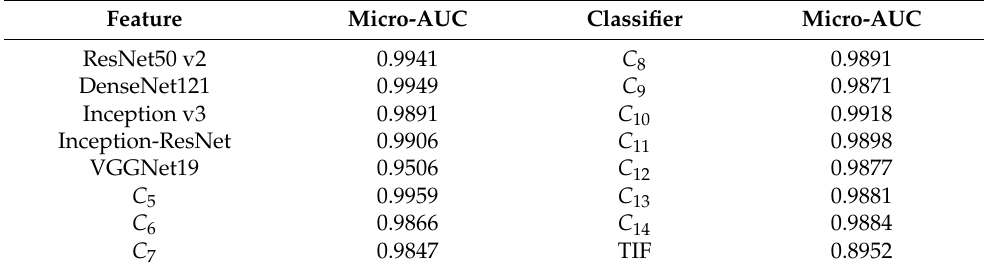
Table 6. Model micro-AUC